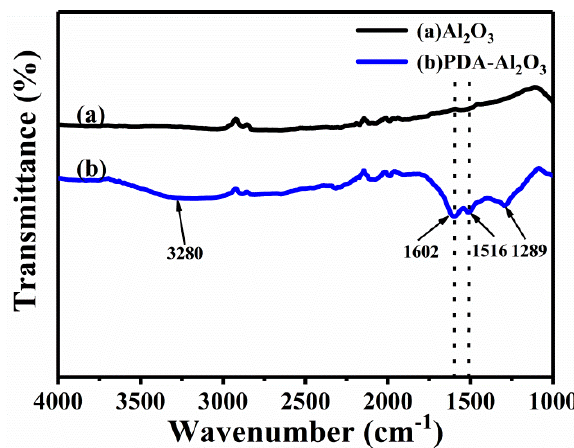
Figure 4. FTIR results for Al 2 O 3 and PDA-Al 2 O 3 .